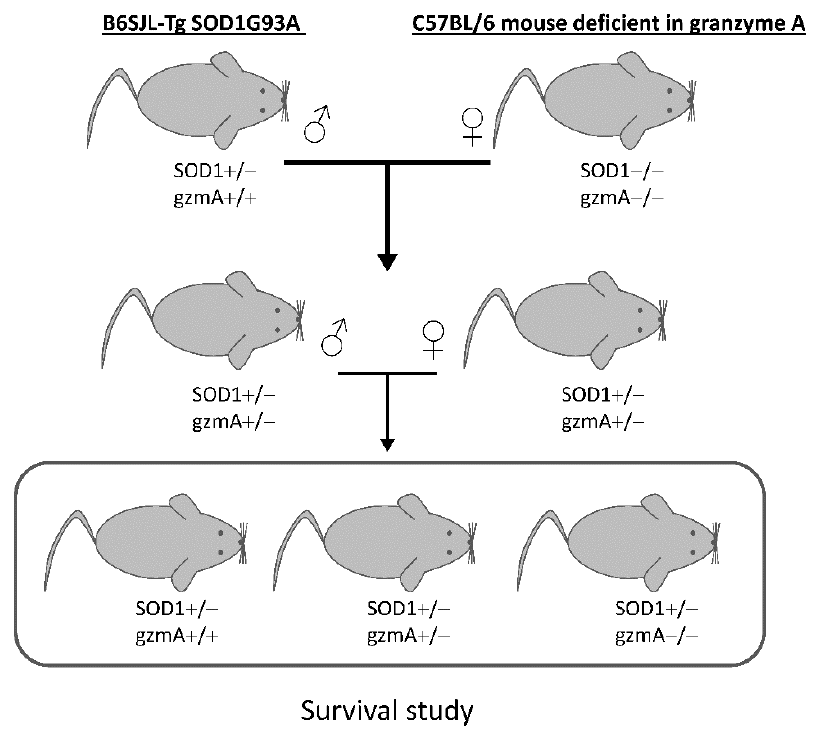
Figure 6. Scheme of crossings to generate homozygous and hemizygous gzmA mice. Hemizygous SOD1G93A males (SOD1+/ − , gzmA+/+) were crossed with C57BL/6 females deficient in gzmA (SOD1 − / − , gzmA − / − ) to obtain hemizygous gzmA mice. Afterwards, we crossed hemizygous SOD1G93A and gzmA mice (SOD1+/ − , gzmA+/ − ) to generate littermate mice with the three gzmA genotypes with the same genetic